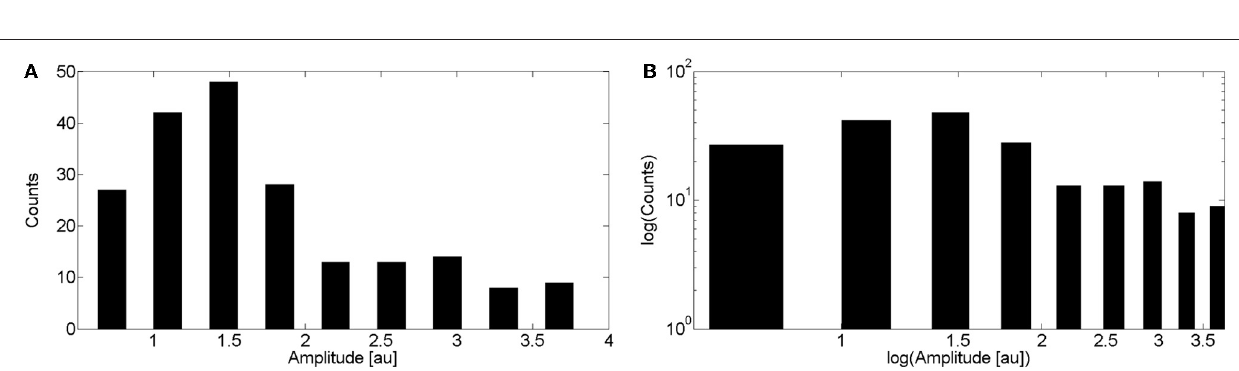
FIGURE 5 | Distribution of puff amplitudes obtained experimentally. (A) Distribution obtained by pooling together data from 202 puffs observed in 13 cells. Experiments were performed as explained in the “Materials and Methods” sections. (B) Same as (A) but on a logarithmic scale.